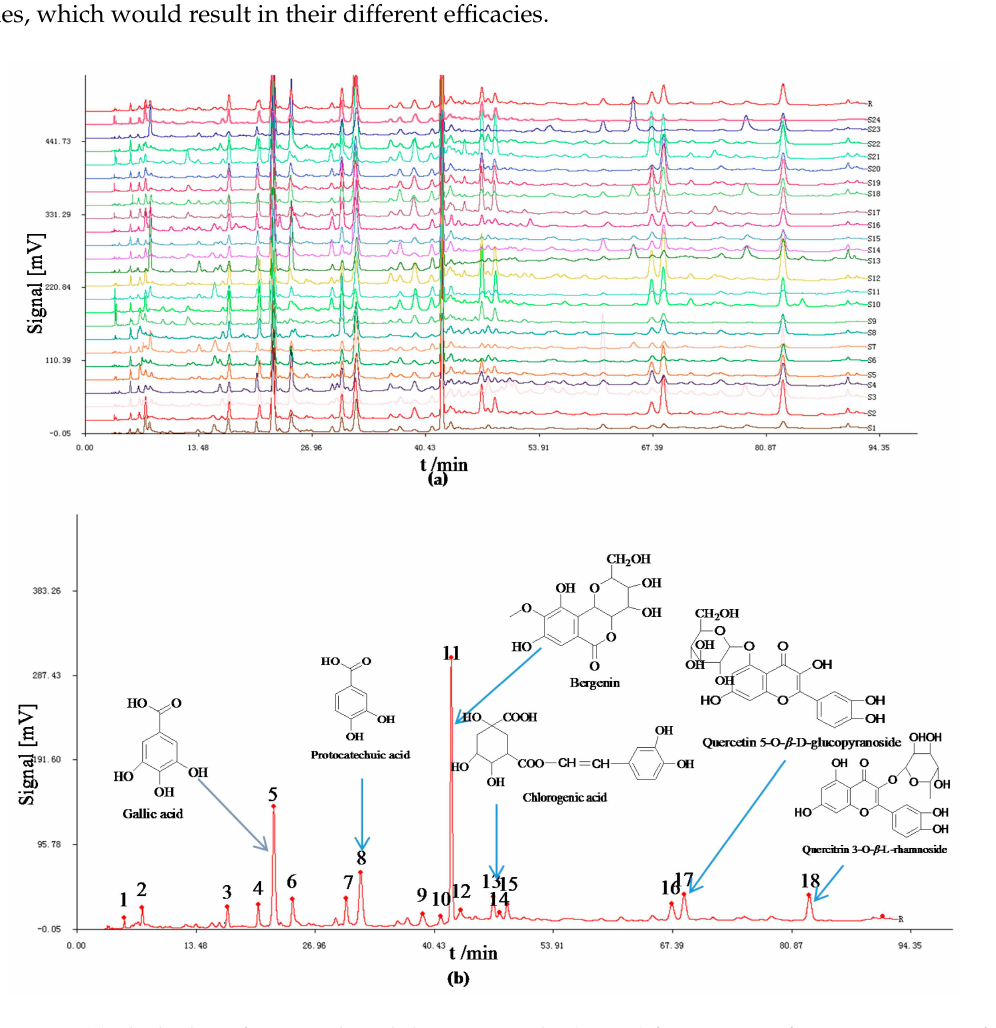
Figure 1. ( a ) The high performance liquid chromatography (HPLC) fingerprints of aqueous extracts of S. stolonifera from various sources; ( b ) The reference chromatogram was generated from the fingerprints of the 24 batches of S. stolonifera samples by using the Similarity Evaluation System for Chromatographic Fingerprint of traditional Chinese medicines (TCM) using the median